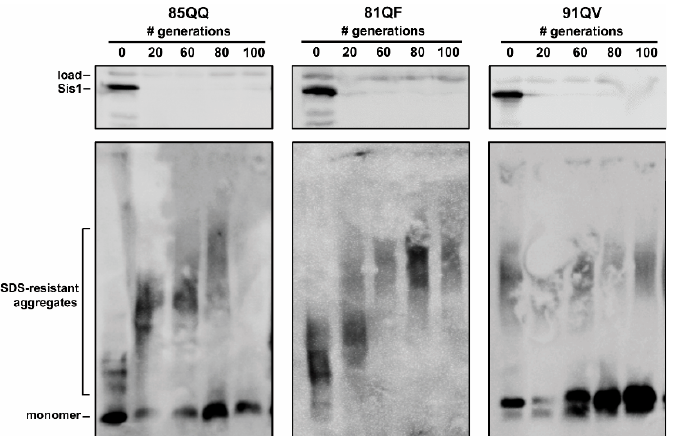
Figure 3. Time courses of SIS1 -repression of cells bearing distinct polyQX prions of 85QQ, 81QF, and 91QV for 100 generation were conducted in triplicate with similar results; representative results are shown. Cells were harvested after the indicated number of generations of growth in the presence of doxycycline and pellets collected for analysis. Lysates were resolved by SDS-PAGE ( top panels ) and SDD-AGE ( bottom panels ). Sup35 and Sis1 were visualized by immunoblotting with Sup35- and Sis1-specific antibodies. A band cross-reacting with the Sis1 antibody is shown as a loading control.